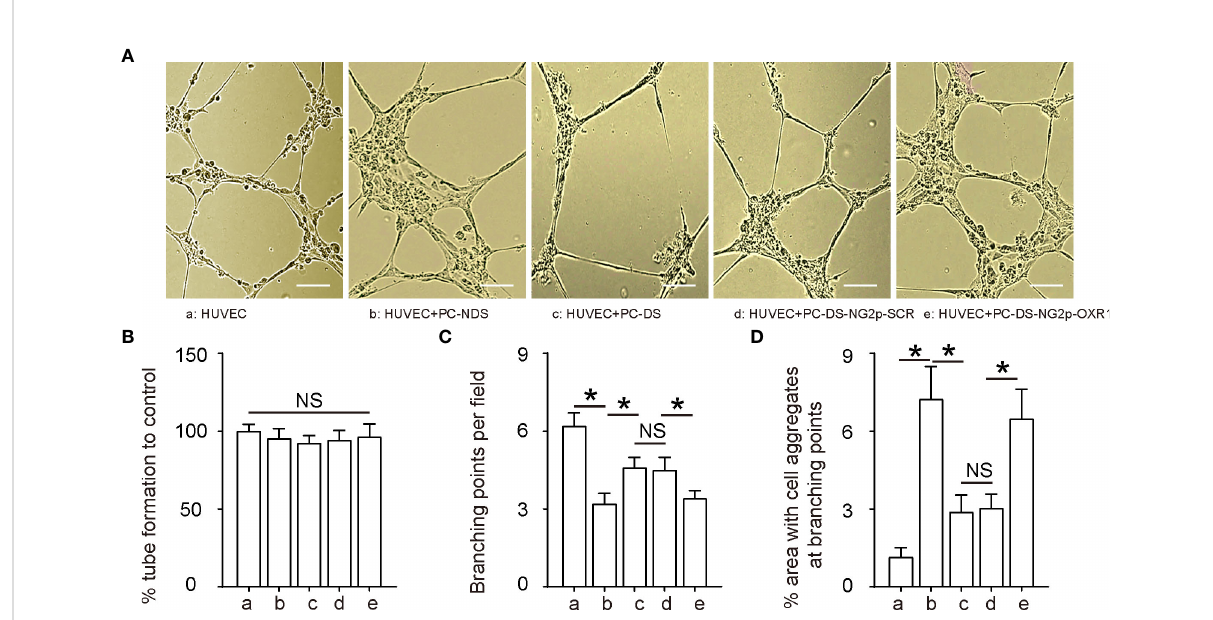
FIGURE 3 OXR1 expression in diabetic pericytes increases aggregates and reduces branching in endothelial cells To assess the effects of relieving oxidative stress in pericytes on angiogenesis, we used pericytes from NDS (PC-NDS), uninfected PC-DS, and PC-DS transduced with either AV-NG2p-SCR or AV-NG2p-OXR1 to co-culture with HUVECs in a tube formation assay. HUVECs alone in culture were also added as a control. (A) Representative images. (B) Percent tube formation. (C) Branching points. (D) Percent area with cell aggregates at branching points. * p < 0.05. NS, no signi fi cance. N = 5. Scale bars are 50